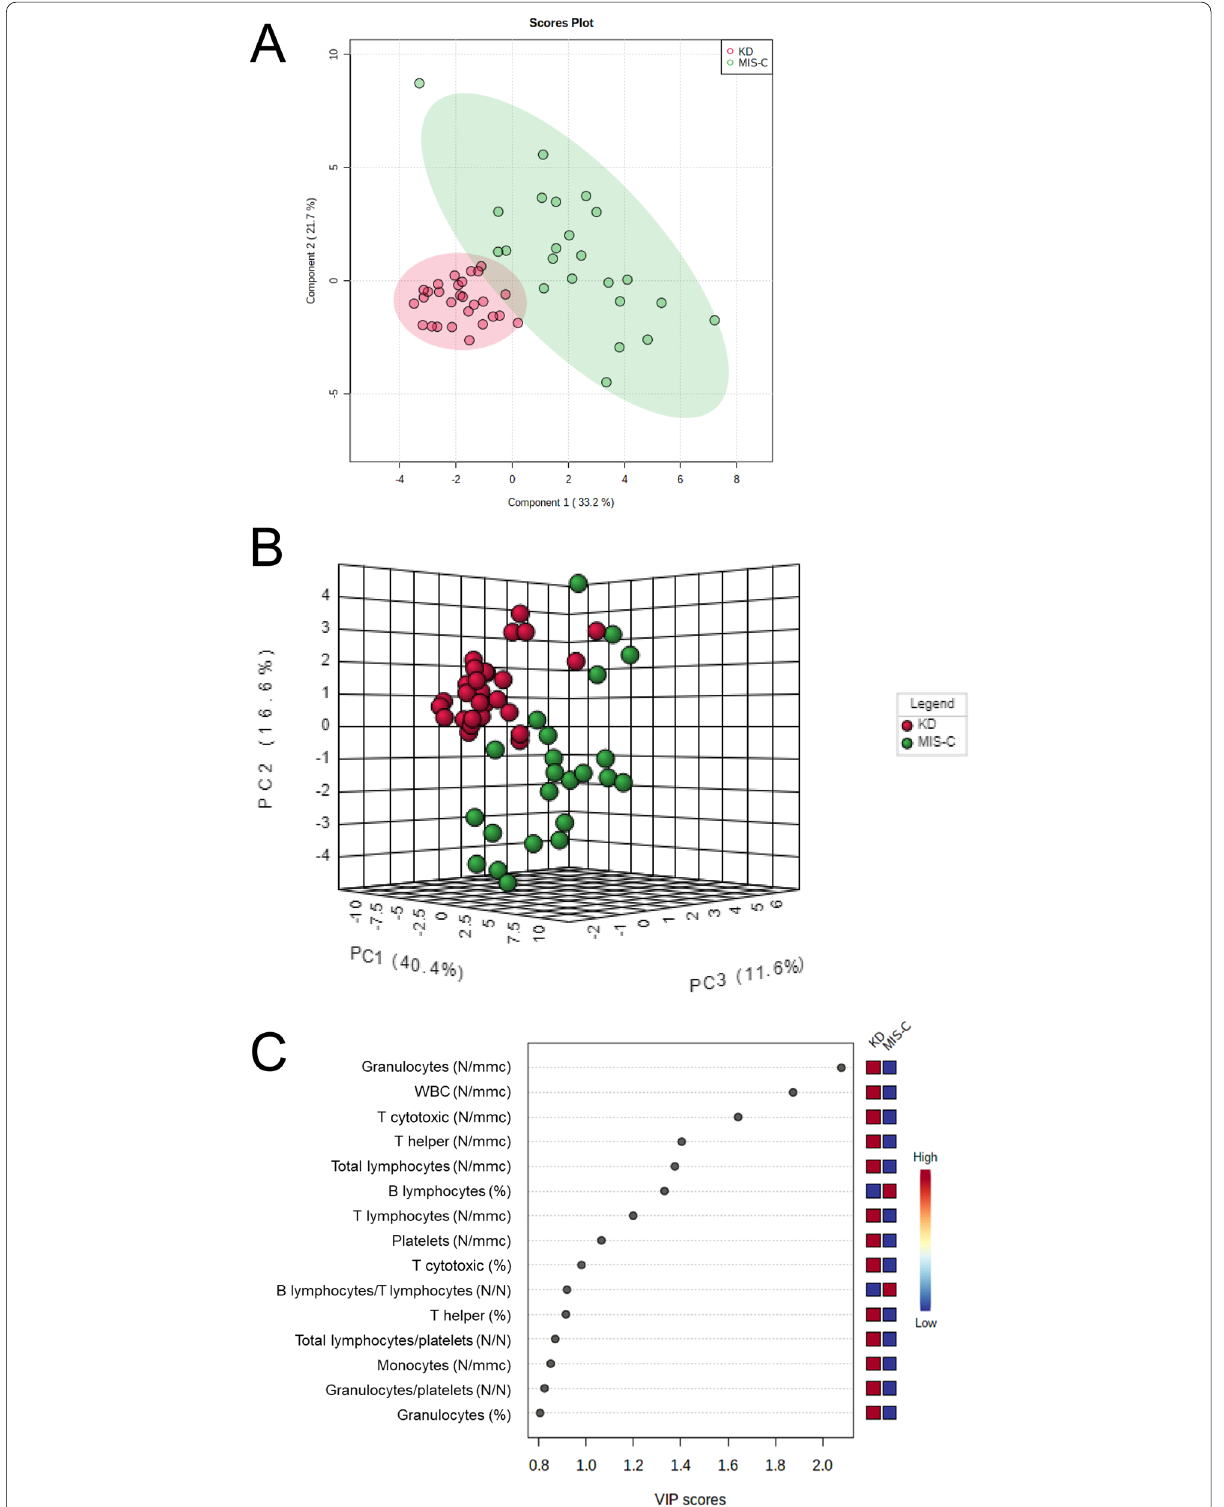
Fig. 2 PLS-DA analysis discriminating KD and MIS-C groups. A : 2D score plot; B : 3D score plot; C : VIP score of the first 15 features. KD: Kawasaki disease; MIS-C: multisystem inflammatory syndrome in children; PC: principal component; PLS-DA: partial least-squares discriminant